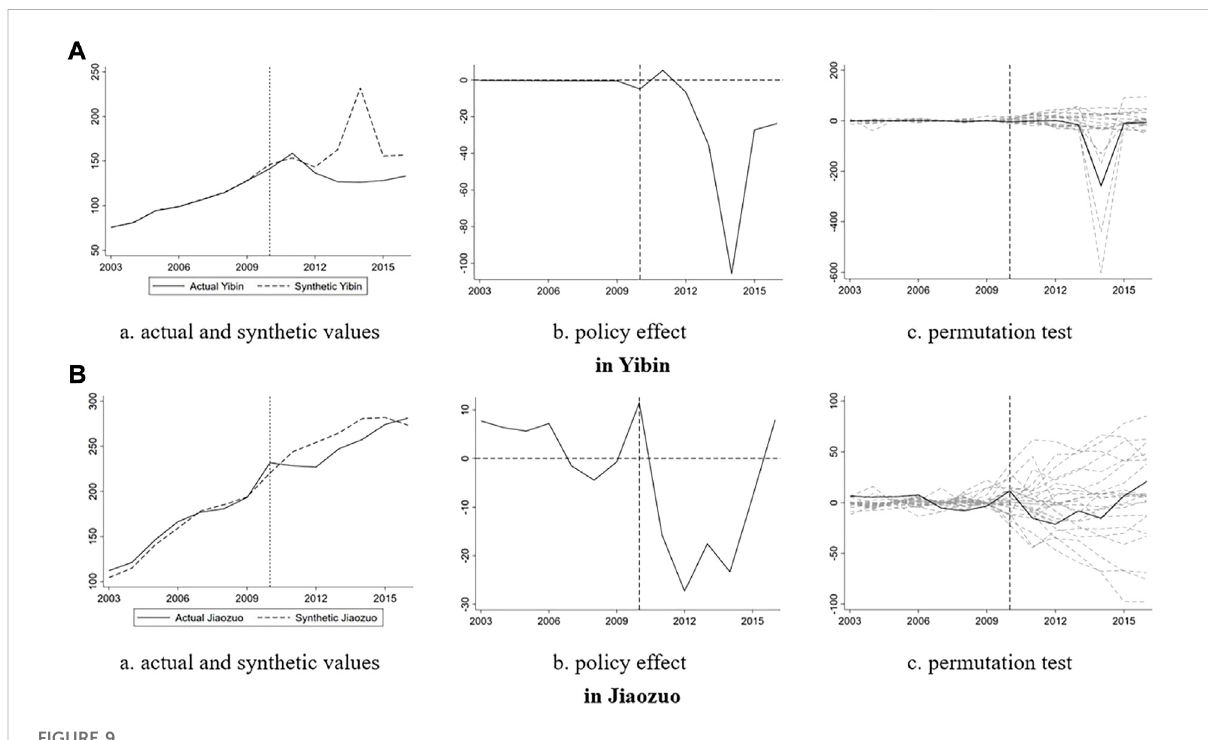
FIGURE 9 Actual and synthetic total industrial